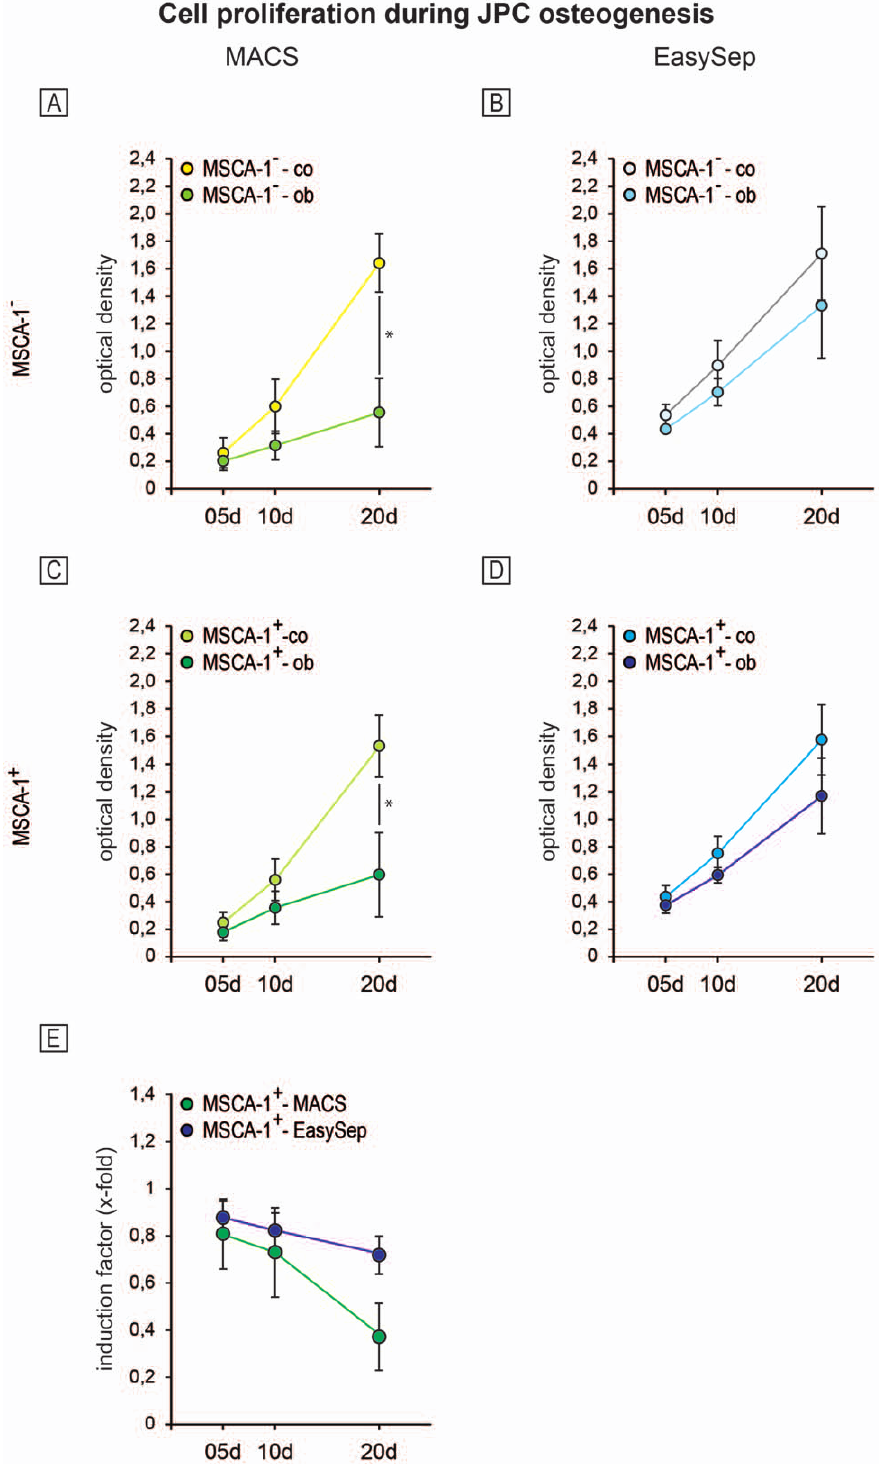
Figure 4. Cell proliferation behaviour during JPC osteogenesis. The proliferation rates (optical densities) of the MACS- (A, C) and EasySep- separated (B, D) MSCA-1 + / 2 cells were analyzed at days 5, 10 and 20 of the osteogenic differentiation (n=4 for each separation method) compared with the untreated controls. The MACS-separated MSCA-1 2 / + cells at day 20 showed significant differences (p , 0,044) between the undifferentiated cells and the osteogenic induced ones for the MSCA-1 2 and MSCA-1 + cells. In contrast, the EasySep-separated MSCA-1 2 / + cells proliferated almost identically in osteogenic stimulated and untreated controls. The significant decrease in proliferation of the MACS-separated compared to the EasySep-separated positive fraction at day 20 is shown in part E of the figure (p , 0.05).